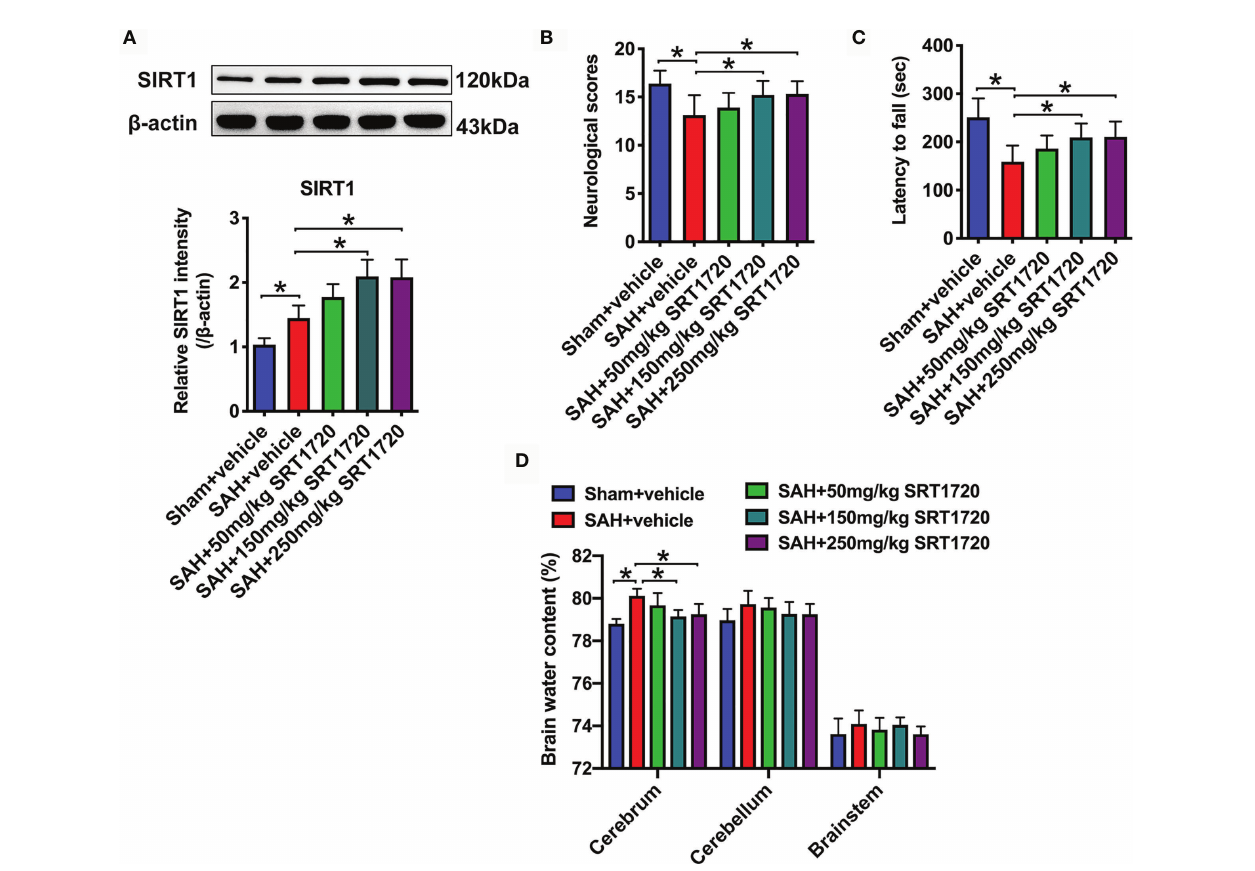
FIGURE 2 | Dose-response effects of SRT1720 on SAH. Representative western blots and quanti fi cation of expression of SIRT1 in all groups (A) . Quanti fi cation of neurological scores (B) , rotarod function (C) , and brain water content (D) in all groups. Bars represent the mean ± SD. * P <